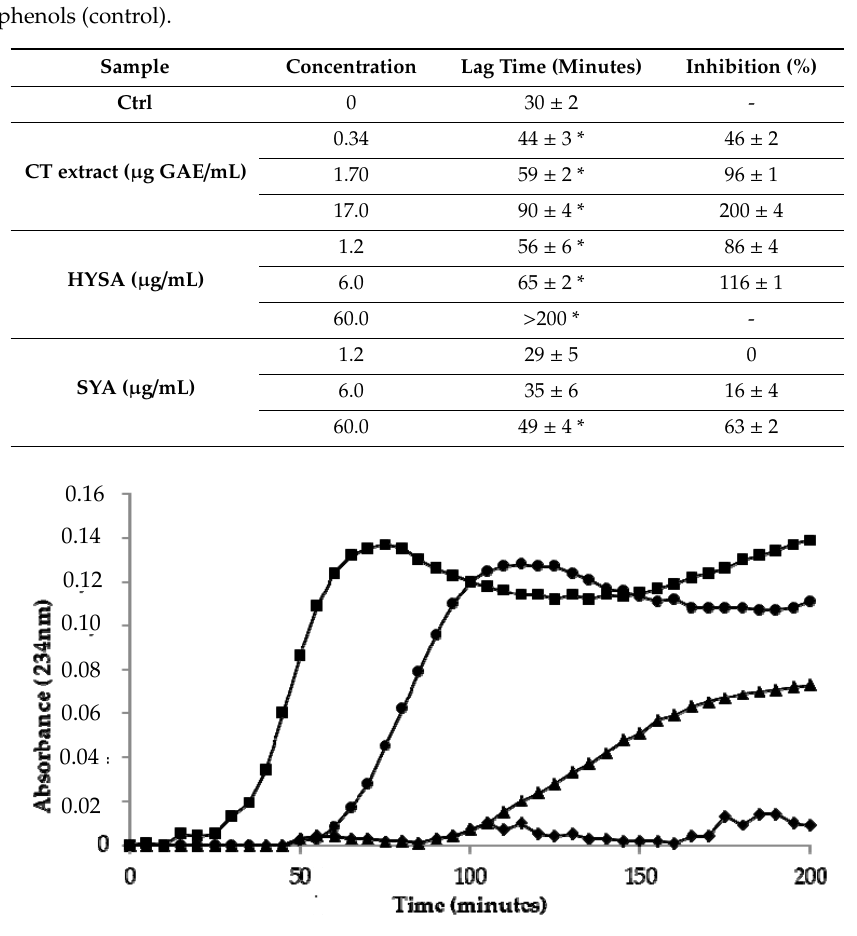
Figure 1. Kinetics of LDL oxidation by 5 µ M CuSO 4 as measured by the formation of conjugated dienes. Control LDL ( (cid:4) ), LDL incubated in the presence of Carthamus Tinctorius (CT) extract (17 µ g gallic acid equivalent / mL ( (cid:78) ), or in the presence of 60 µ g / mL of hydroxy sa ffl or yellow A (HSYA) ( (cid:7) ) or sa ffl or yellow A (SYA) ( • ). Table 3. Lag time and percentage of inhibition of conjugated dienes formation in Cu ++ —triggered LDL oxidation in the absence or in the presence of increasing concentrations of Carthamus Tinctorius (CT) extracts, hydroxy safflor yellow A (HSYA) and safflor yellow A (SYA). Phenolic concentrations of CT extract are expressed as μ g gallic acid equivalent (GAE)/mL. * p < 0.05 vs. LDL oxidized in the absence of polyphenols (control). Sample